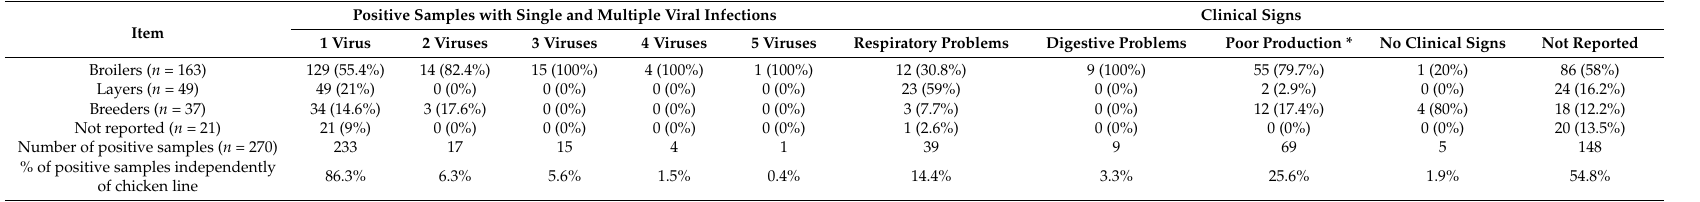
Table 6. Frequency of single and multiple virus infections and clinical signs according to the type of birds.